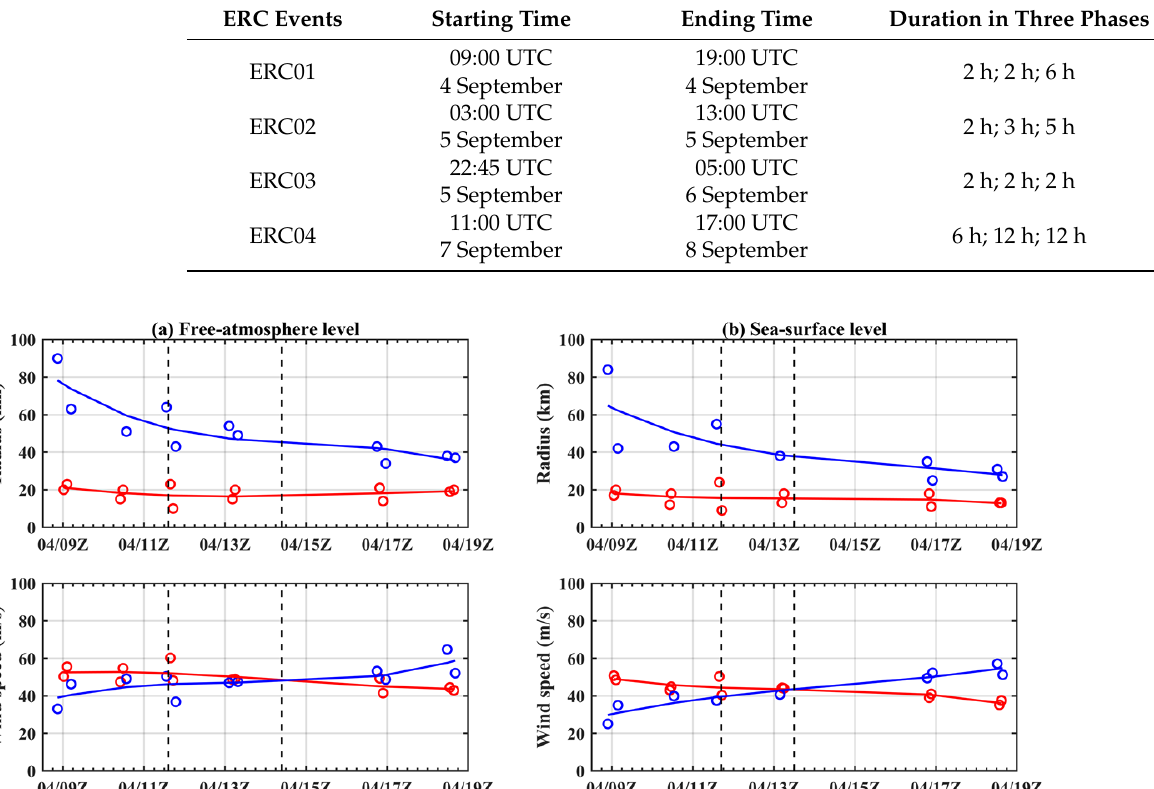
Table 3. Start/end time and duration of the three phases of four ERC events.